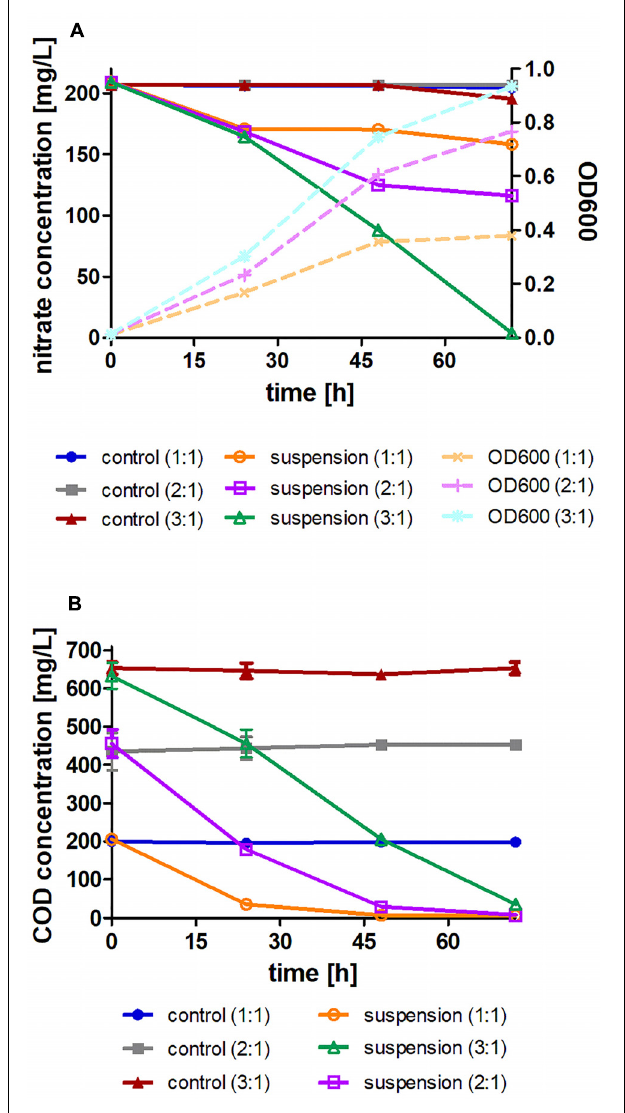
FIGURE 3 | Flask experiment. (A) Nitrate concentration over time, where the initial concentration was 200 mg/l; treatment vs. sterile control with three different C:N ratios (1:1, 2:1, 3:1); estimation of bacterial biomass growth in suspension is presented as OD600. (B) COD concentration over time with the initial concentration varying according to the C:N ratio; treatment vs. sterile control at three different C:N ratios (1:1, 2:1, 3:1). The data are means of three replicates + standard